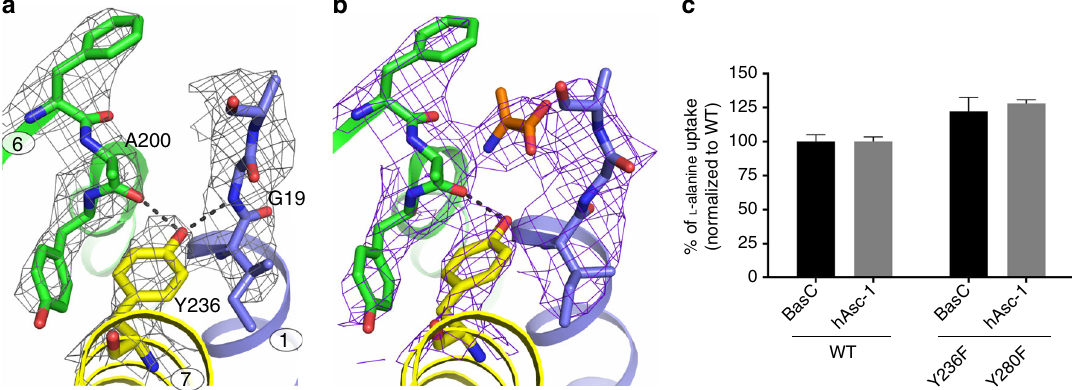
Fig. 4 Structural and functional interactions of Tyr 236. 2Fo-Fc density maps contoured at 1 σ for the BasC binding site residues in apo at 2.9 Å (gray) ( a ) and 2-AIB bound at 3.4 Å (purple) ( b ) structures. c 10 µ M [ 3 H] L -alanine/4 mM L -alanine exchange by wild-type (WT) and Y236F mutant BasC reconstituted in proteoliposomes (black bars) and transport of 10 µ M [ 3 H] L -alanine in HeLa cells by human Asc-1 (hAsc-1) WT and Y280F mutant (gray bars). Data (mean ± s.e.m.) normalized to WT values from 3 independent experiments. Source data are provided as a Source Data fi